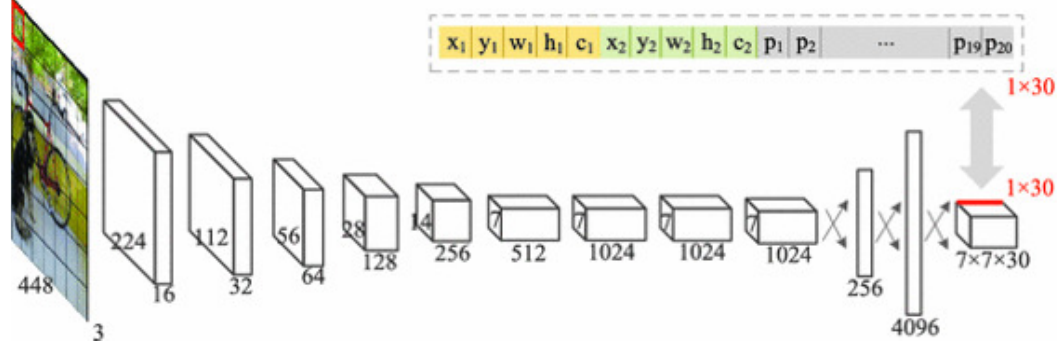
Figure 4. YOLOv1 architecture for object detection